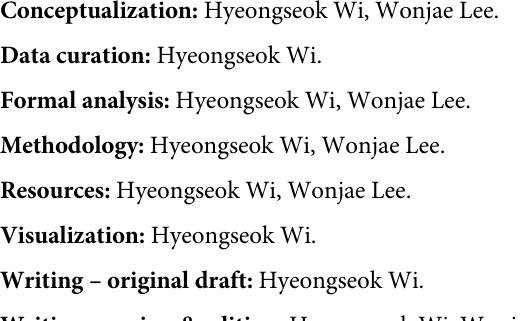
S1 Table. Descriptive statistics of variables. (N =